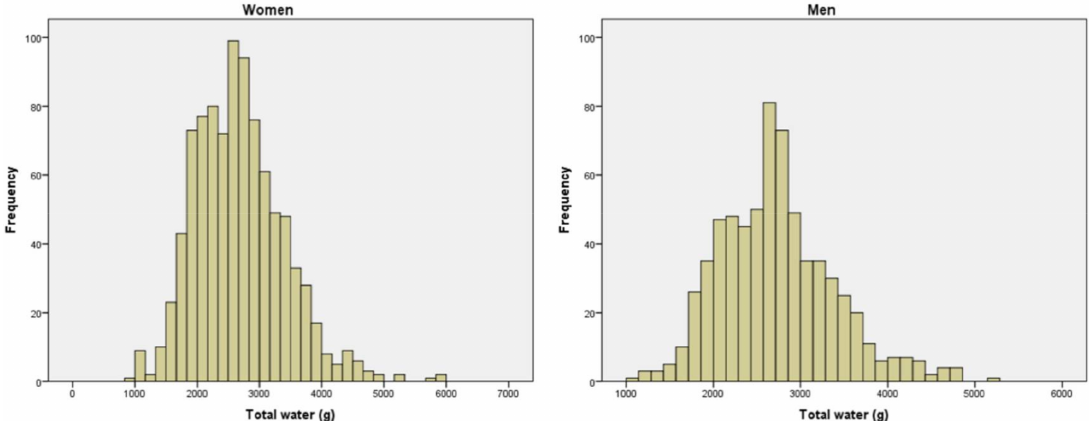
Figure 1. The frequency distribution of total water intake